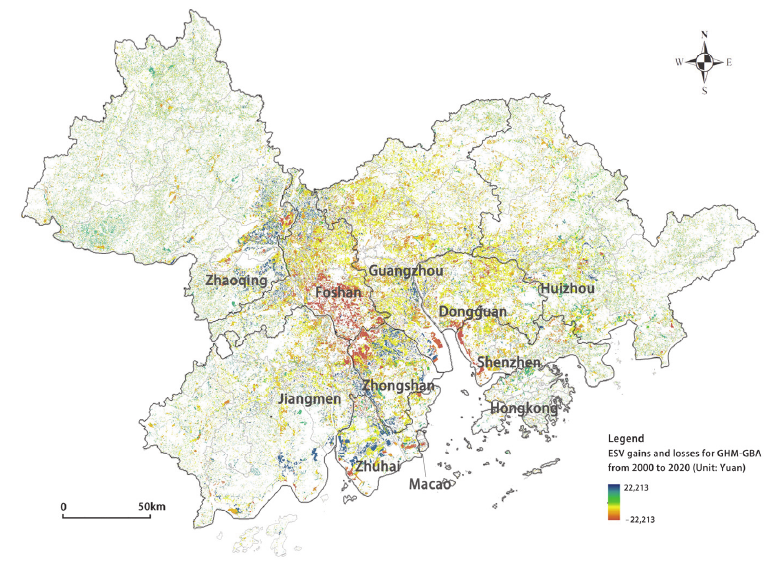
Figure 8. ESV gains and losses for the GHM-GBA from 2000 to 2020.